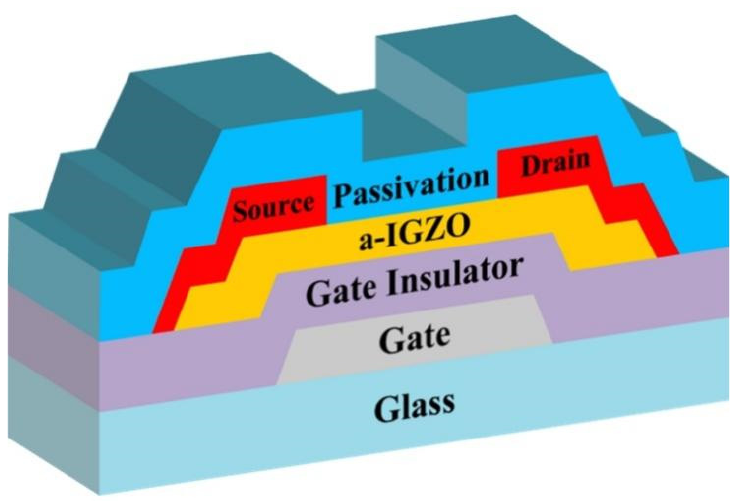
Figure 1. Schematic cross-section of the back-channel-etching (BCE) -structured amorphous InGaZnO thin-film transistors (a-IGZO TFTs) in this study. The electrical performance and PBS stability of the a-IGZO TFTs were measured by a Keithley 2636 analyzer. The transfer curves were obtained when V GS was scanned from − 20 V to 40 V at a step of 0.5 V and V DS was set to 10 V. During the PBS tests, the transfer curves were instantly measured following each 1500 s’ stressing (V GS = +40 V). All the above tests were performed in a dark chamber at RT. An XPS analyzer (AXIS Ultra DLD) was used to characterize the chemical bonding states of the a-IGZO films (without or with passivation layers) annealed under different atmospheres. Here, an X-ray source with the aluminum anode was used to bombard the film surface and obtain the energy spectrum of different elements. The binding energy of all elements were calibrated using the C1s peak at 284.8 eV. A SIMS measurement system (TOF SIMS 5 produced by ION-TOF GmbH) with a Cs + primary ion source was applied to measure the depth profiles of different